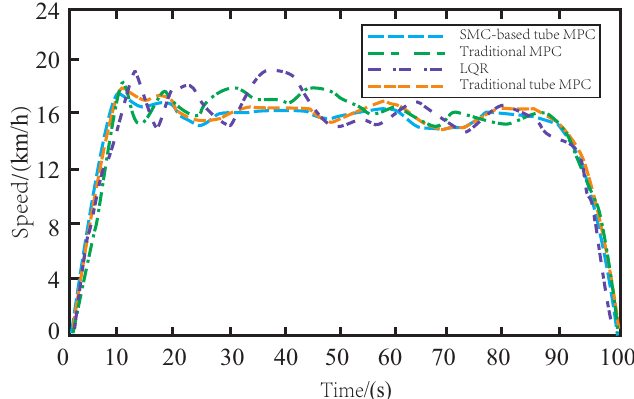
Figure 9. The variation of speed on the snowy road.